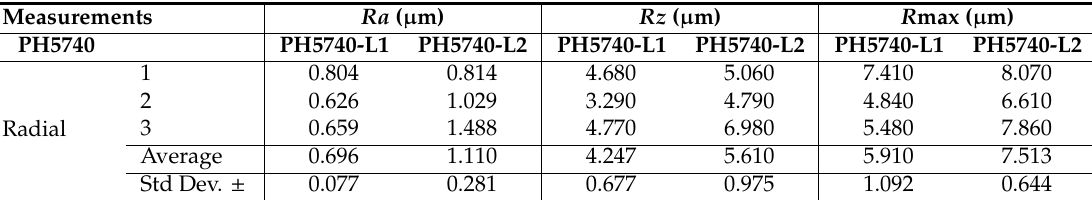
Table 10. Surface roughness of PH5740 CVD TiN / TiCN / Al 2 O 3 coated inserts with a cutting length of 7,87 m